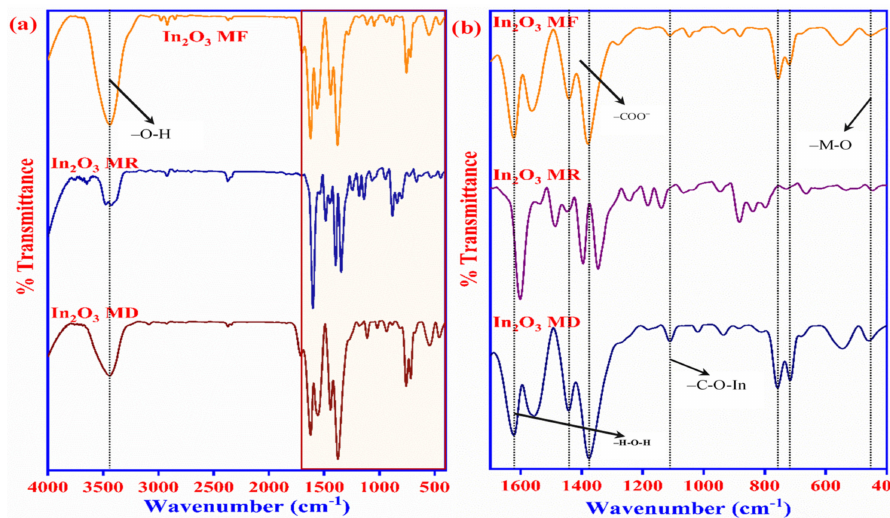
Figure 2. FTIR spectra of the In 2 O 3 -MF, In 2 O 3 -MR, and In 2 O 3 -MD ( a ), Enlarged FTIR spectra of In 2 O 3 -MF, In 2 O 3 -MR, and In 2 O 3 -MD ( b ).